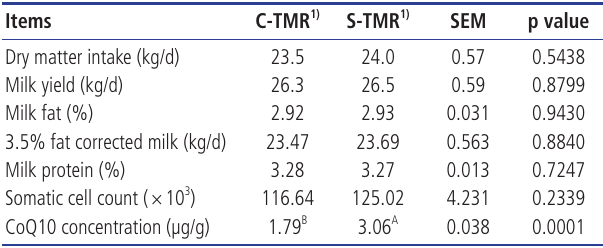
Table 3. Effects of supplementation of Rhodobacter sphaeroides KTCT 1434 on total mixed ration (TMR) on milk yield, milk composition and CoQ10 concentration in milk of lactating